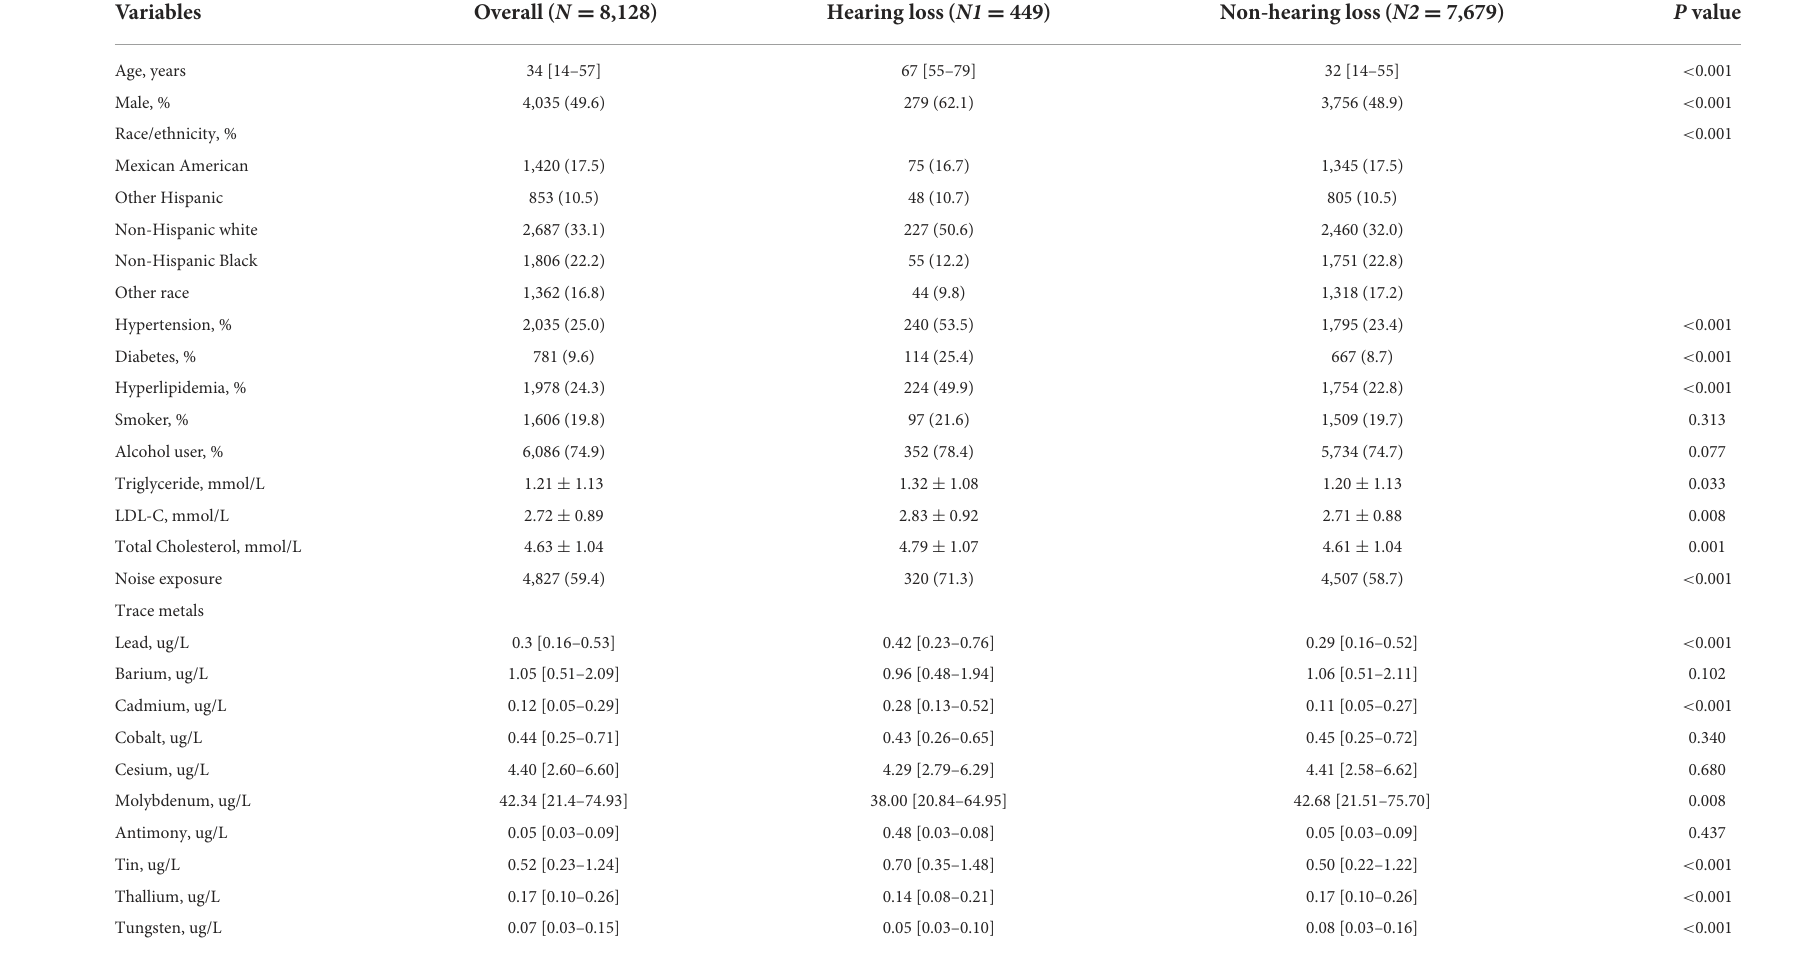
TABLE 1 Baseline characteristics of the study